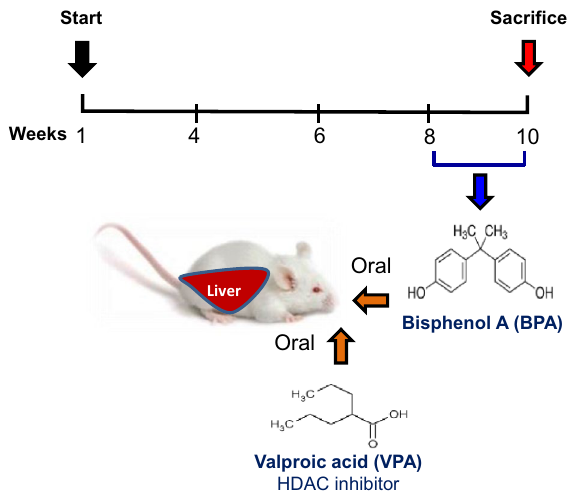
Figure 6. Schematic of animal treatment procedure. At 8 weeks old, mice were exposed to different treatments: sham, vehicle, VPA, BPA, or BPA + VPA. BPA and VPA were administered orally via gavage at a single dose of 4 mg/kg and 4 µg/kg for 2 weeks, respectively. At 10 weeks of age, the mice were euthanized and tissues were collected for biochemical and histological examinations. VPA valproic acid, BPA bisphenol